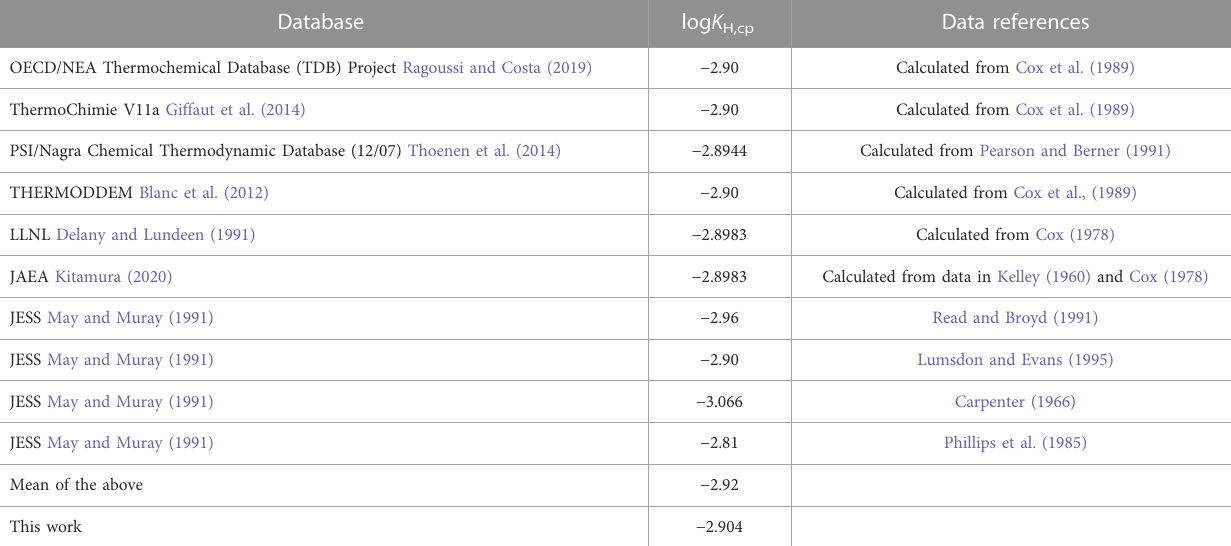
TABLE 3 Comparison of the logarithmic Henry ’ s law constant (log K H,cp ) for the O 2 solubility in pure water at T = 298.15 K used in different thermodynamic database projects and other sources. Database log K H,cp Data references − 2.90 Calculated from Cox et al.